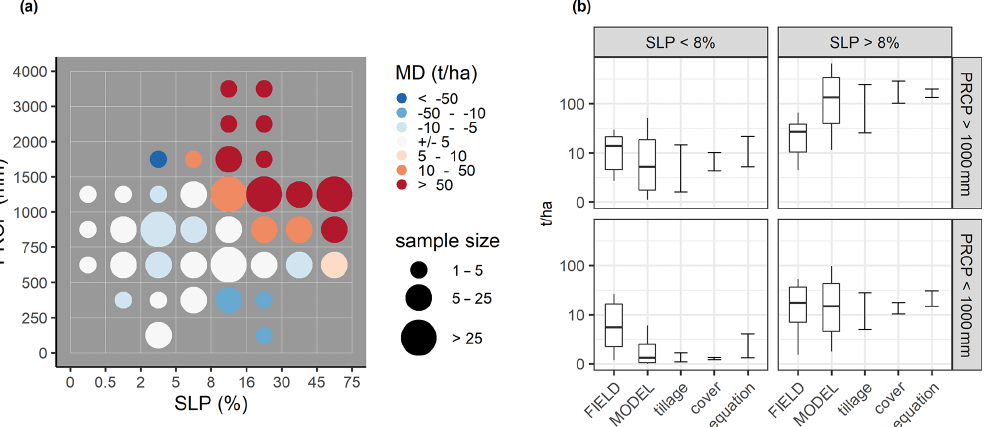
Figure 6. Comparison of simulated erosion with measured erosion. (a) Median deviation (MD) (tha 1 ) between simulated erosion using the baseline scenario and measured erosion. Simulated and measured data are grouped into precipitation classes and slope classes used for the simulation setup. (b) Distributions of measured erosion rates, erosion rates simulated with the baseline scenario and uncertainty ranges for management assumptions and erosion equations. The boxplots are defined by the median, the 25th percentile and the 75th percentile of simulated and measured erosion rates. Whiskers illustrate the 10th and 90th percentiles. The three bars next to the boxplots illustrate minimum and maximum median erosion rates calculated with all tillage and cover crop scenarios and with all water erosion equations. The values have been log-transformed for better